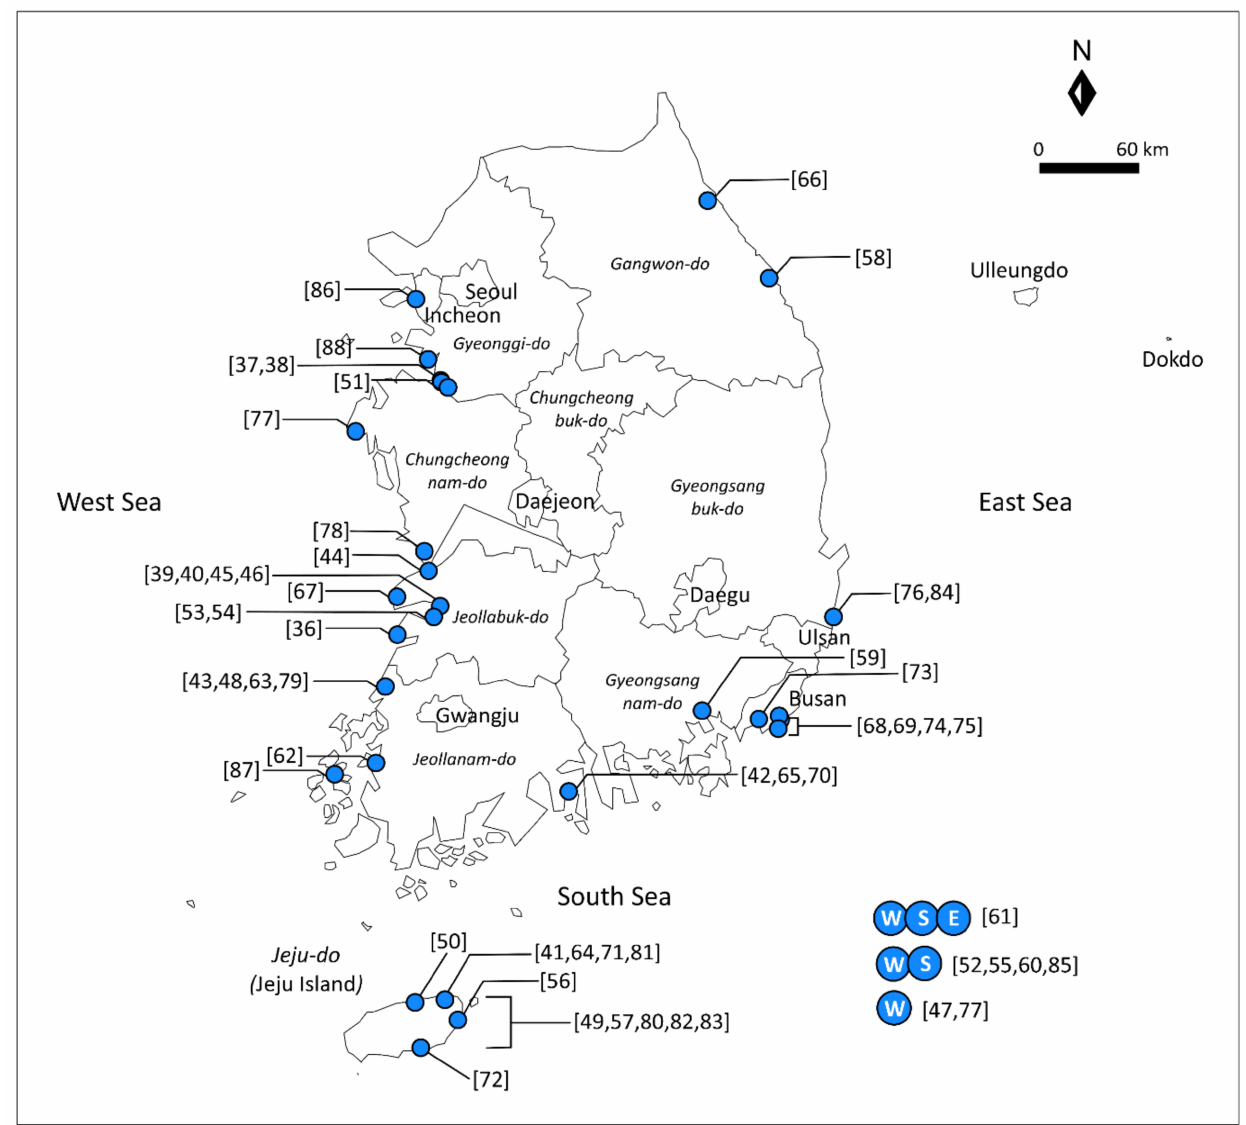
Figure 1. Locations of the seawater intrusion study sites in South Korea (W: western coastal region; S: southern coastal region; and E: eastern coastal